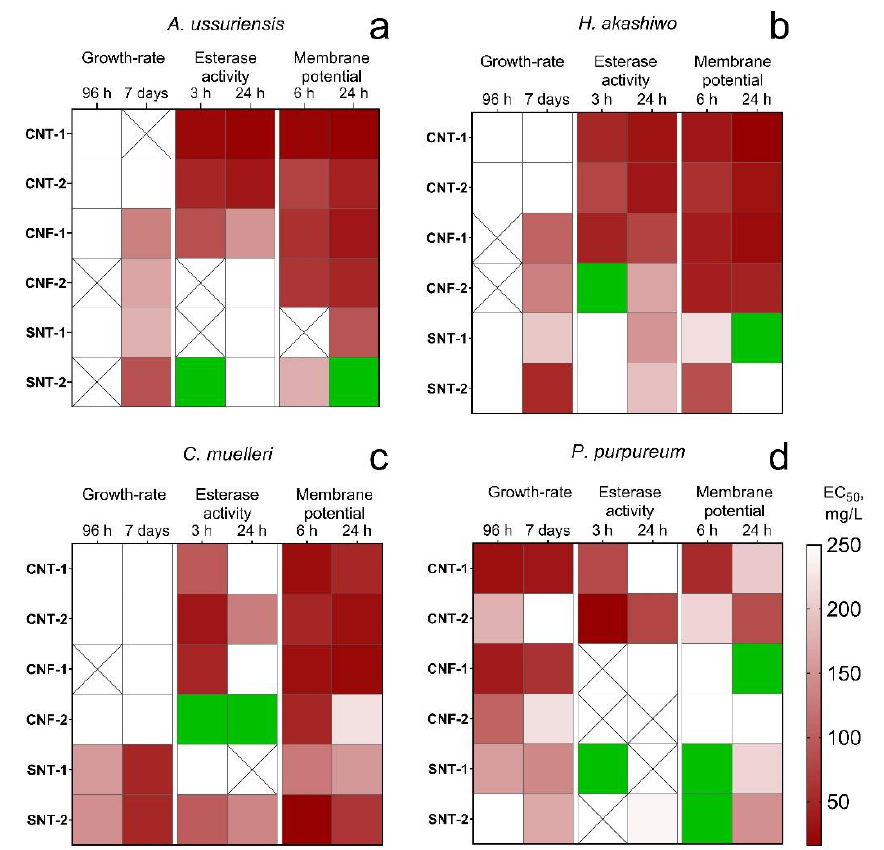
Figure 1. The heatmap of changes in microalgae state after the treatment with the NPs: ( a ) A. ussuriensis ; ( b ) H. akashiwo ; ( c ) C. muelleri ; ( d ) P. purpureum ; white square, the calculated EC 50 was higher than 250 mg/L; crossed square, measured endpoint was not observed; green square, the influence of the NPs caused the stimulation of the measured endpoint.